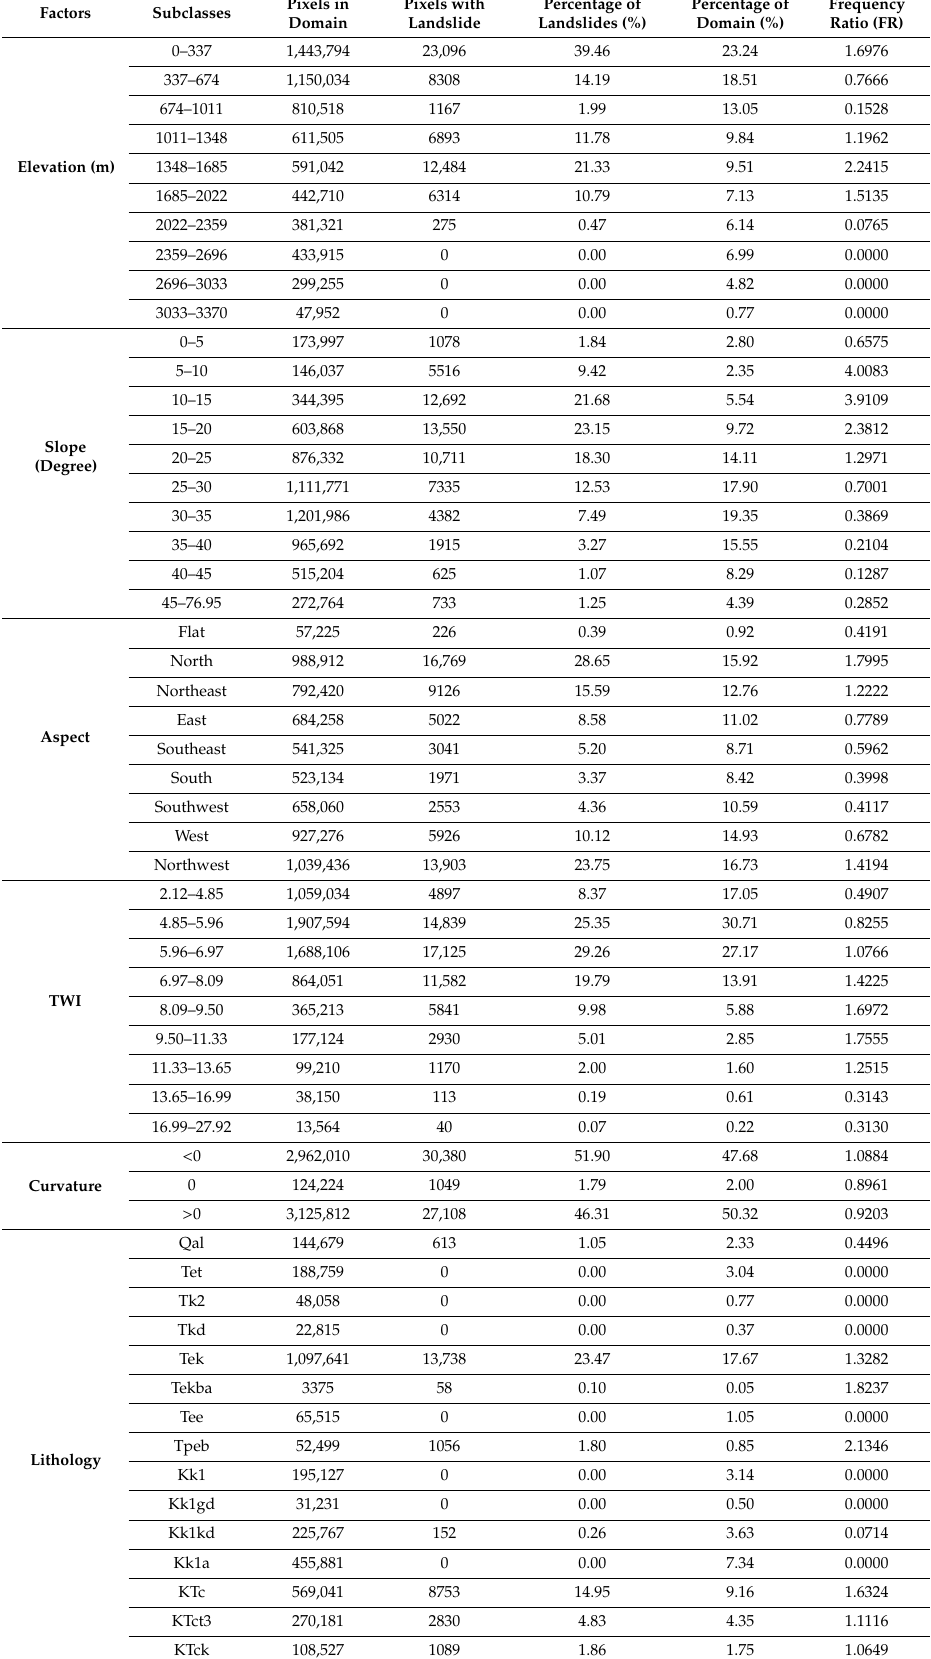
Table 1. Spatial relationship between landslide-conditioning factors and